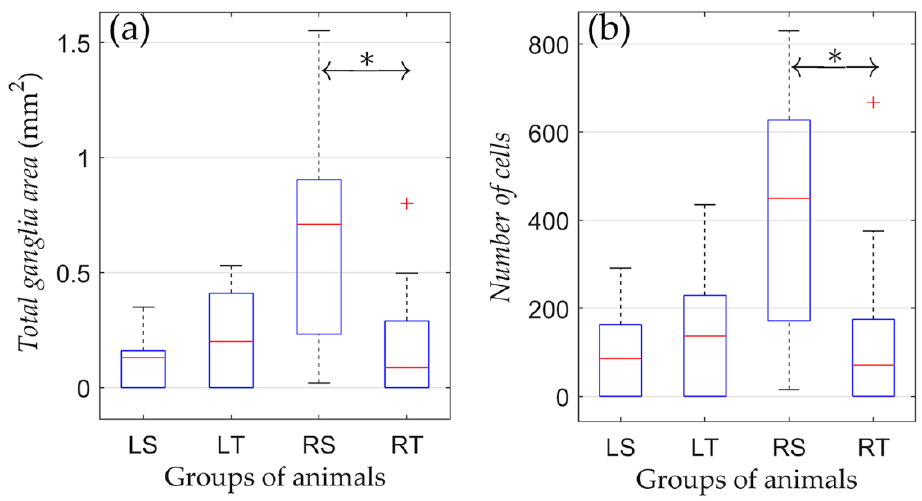
Figure 4. Changes in morphometric parameters due to training in rats from groups of left-sided and right-sided vagotomy. ( a ) Total ganglia area and ( b ) number of cells. On each box, the central mark indicates the median, and the bottom and top edges of the box indicate the 25th and 75th percentiles, respectively. The whiskers extend to the most extreme data points not considered outliers, and the outliers are plotted individually using the ‘+’ symbol. *: p < 0.05.